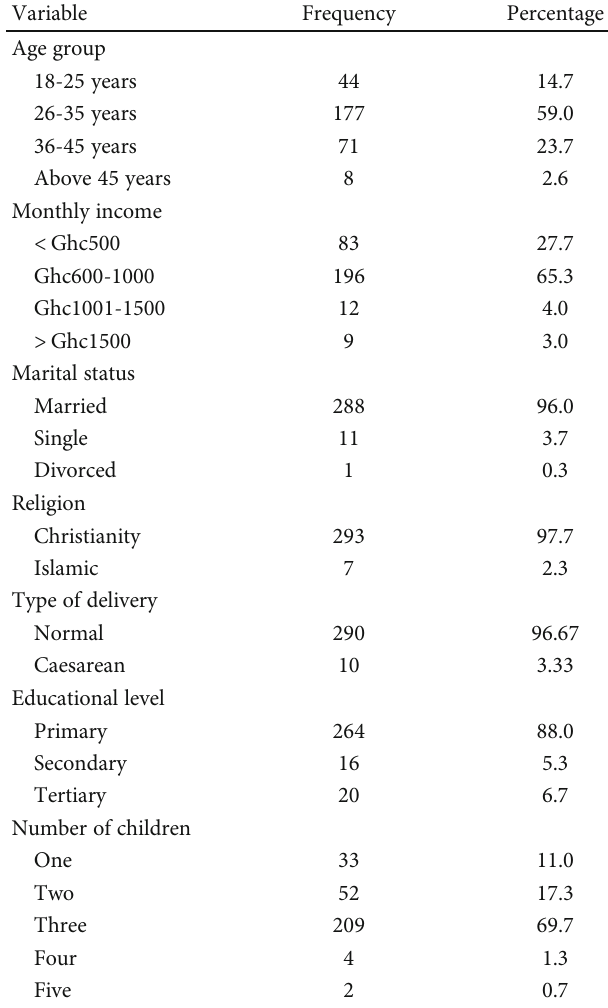
Table 1: Demographic characteristics of